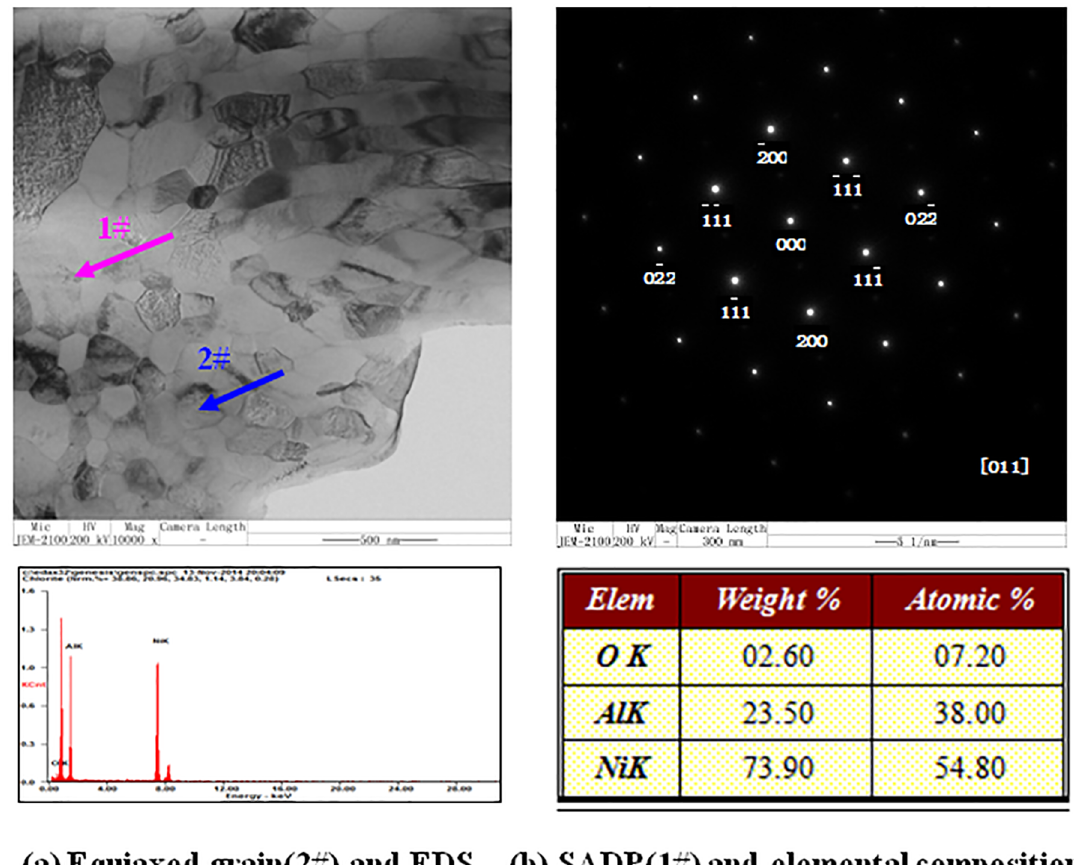
Figure 13. TEM morphology and electron diffraction of the as-prepared coating for (a) and (b). field emission double-beam scanning electron microscopy was used to further observe the surface morphology of the coating. The process parameters are shown in Table 4. Among them, the bottom layer is Ni-5wt.% Al, the surface layer is Ni-20wt.% Al, the spraying voltage is 30V, and the spraying current is 200A. There are nine different spraying process parameters, the surface layer is expressed by S1~S9. Table 4. Spraying parameters of Ni-Al coatings. Layer